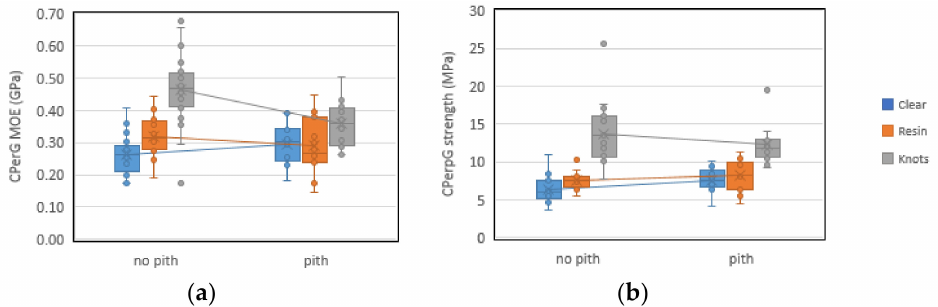
Figure 21. Box plots of CPerpG properties with and without pith—( a ) MOE and ( b )